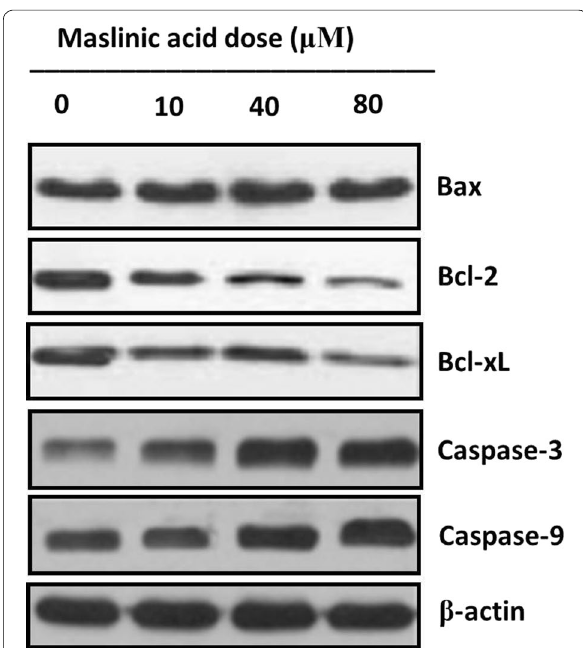
Fig. 6 Activity of the proteins allied with apoptosis (pro as well as anti) at indicated maslinic acid doses. For maximum precision three individual experiments were executed